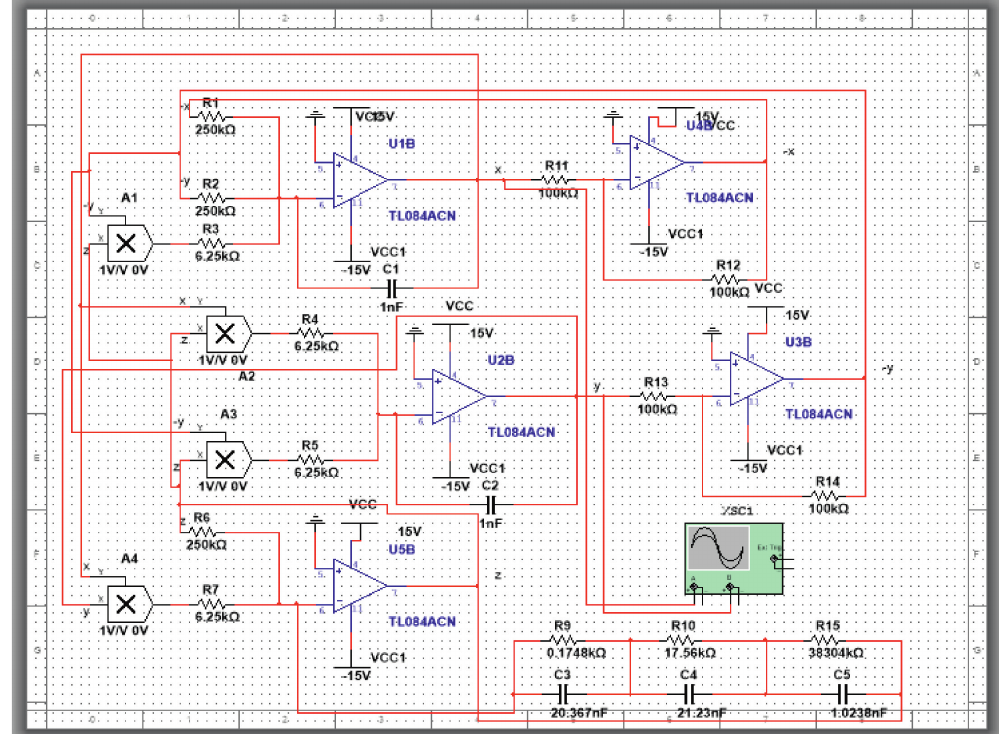
Figure 12: Circuit schematic for fractional-order system